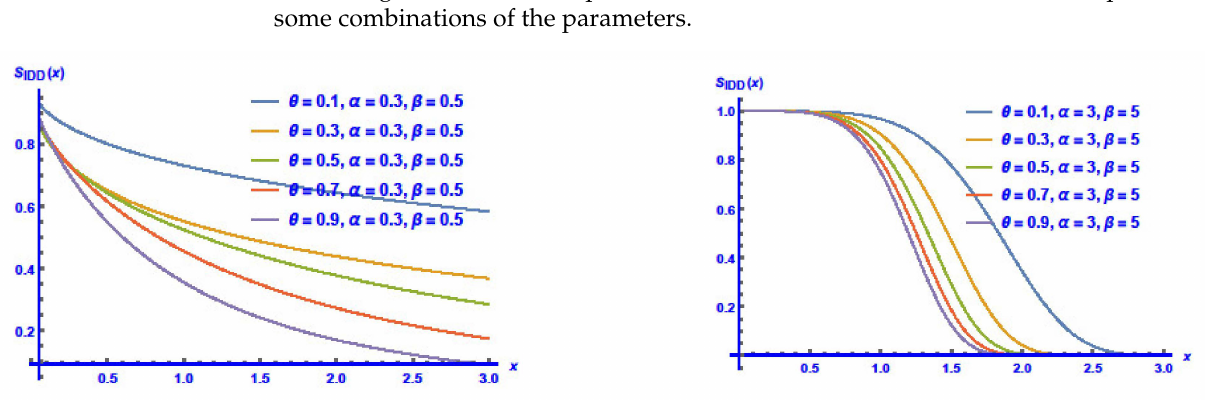
Figure 4. The survival function plots of the PDD for some values of